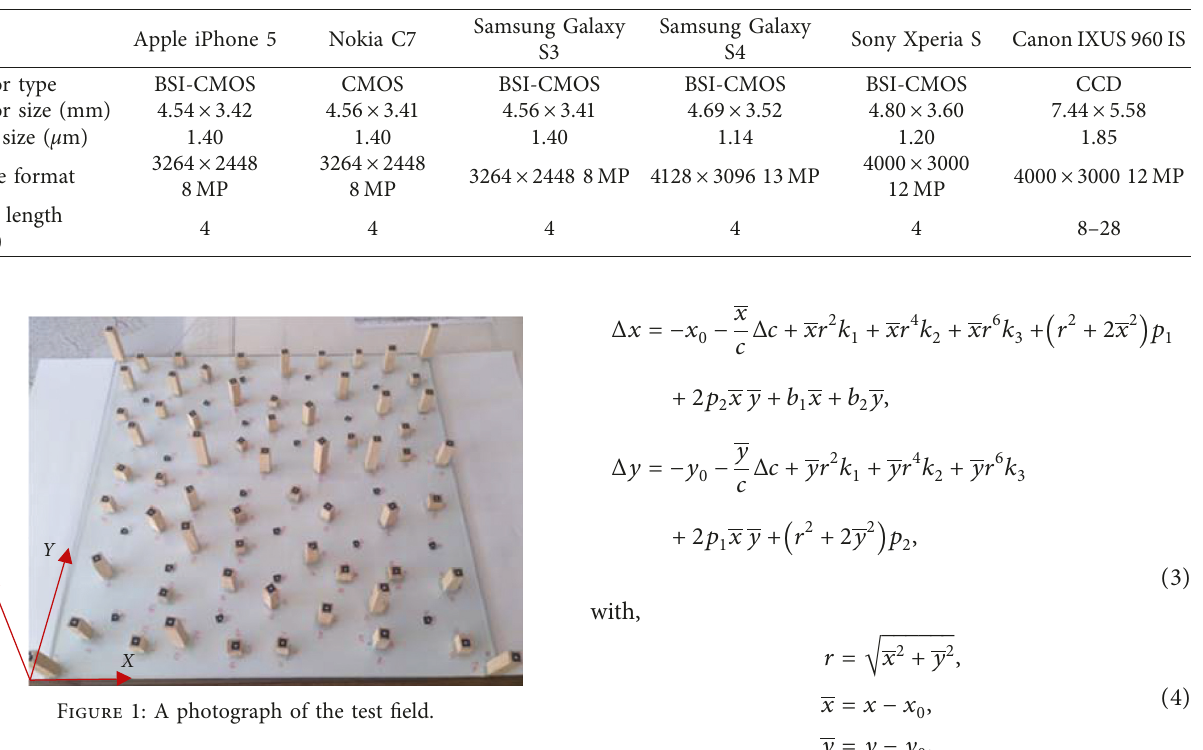
Table 1: Technical specifications of the camera used herein.